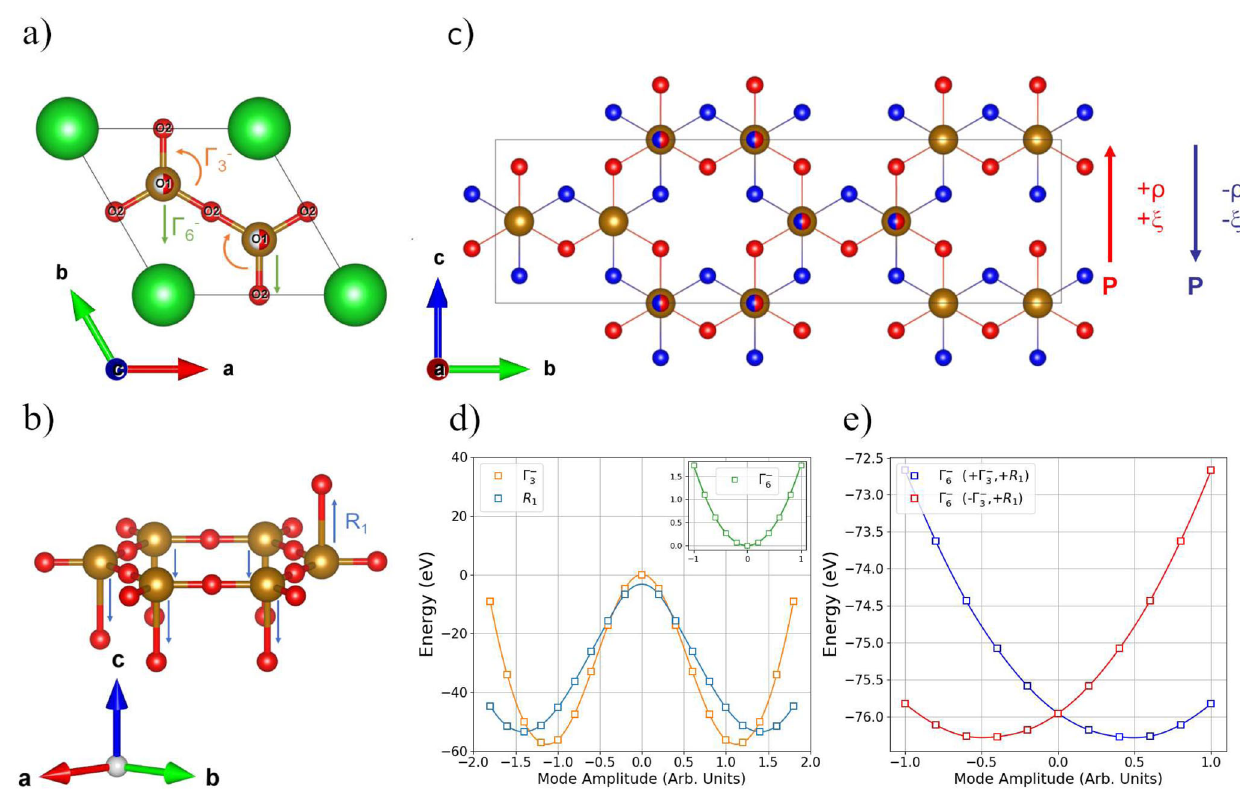
Fig. 4 | Polarization switching mechanism in γ -BaFe 2 O 4 . a Disordered “ latent ” parent structure of BaFe 2 O 4 described in the P6 3 /mmm space group. The orange and green arrows denote the displacements due to the Γ 3 - and Γ 6 - modes. b O1 ordering and relative atoms displacements due to the R1 symmetry modes (blue lines). c Up (red oxygen positions) and down (blue oxygen positions) polarization states related by the rotation of the basal O2 positions as described by the F coup